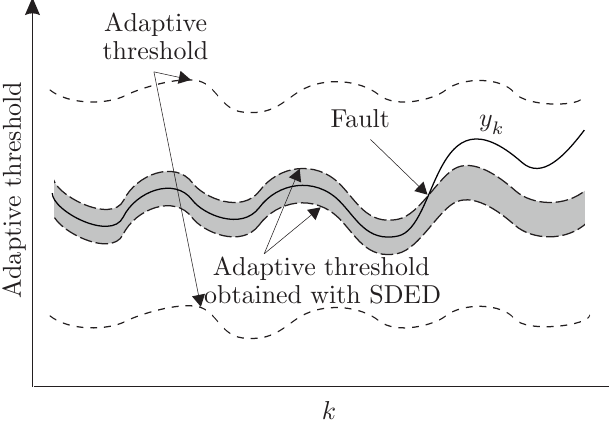
Figure 3. Application of the adaptive threshold for the